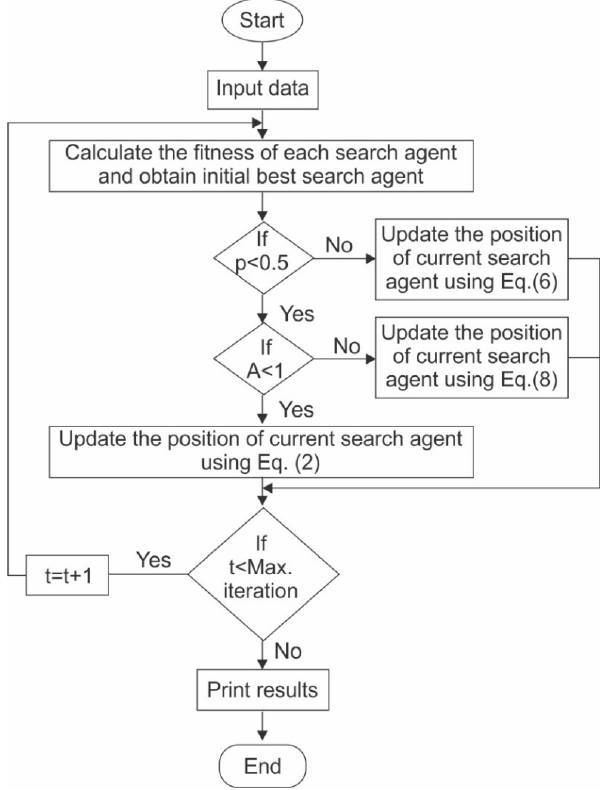
Figure 6. Flowchart of the Whale Optimization Algorithm (WOA) algorithm.